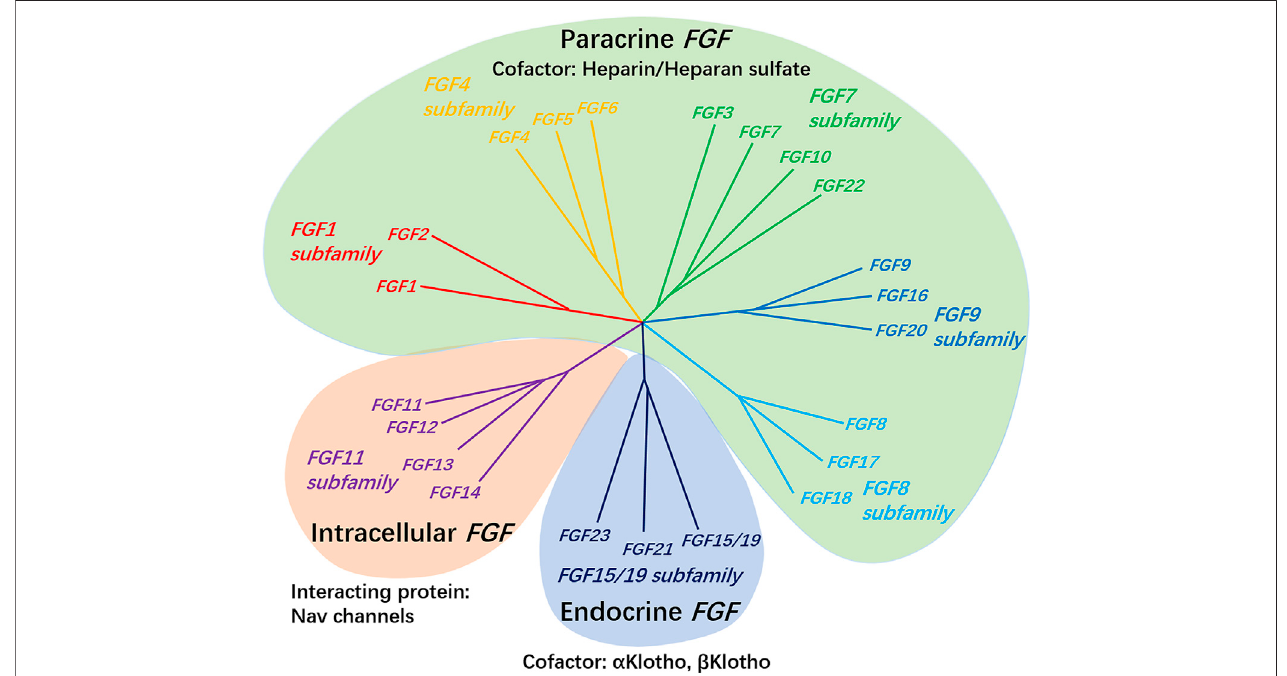
FIGURE1| TheFGF1,FGF4,FGF7,FGF8,andFGF9subfamilygenesencodesecretedparacrineFGFs,whichbindtoandactivateFGFRswithheparin/HSasa cofactor. The FGF 15/19 subfamily members encode endocrine FGFs, which combine and activate FGFRs with the Klotho family protein as a cofactor. The FGF 11 subfamily genes encode intracellular FGFs, which are non-signaling proteins serving as cofactors for voltage-gated sodium channels and other molecules.